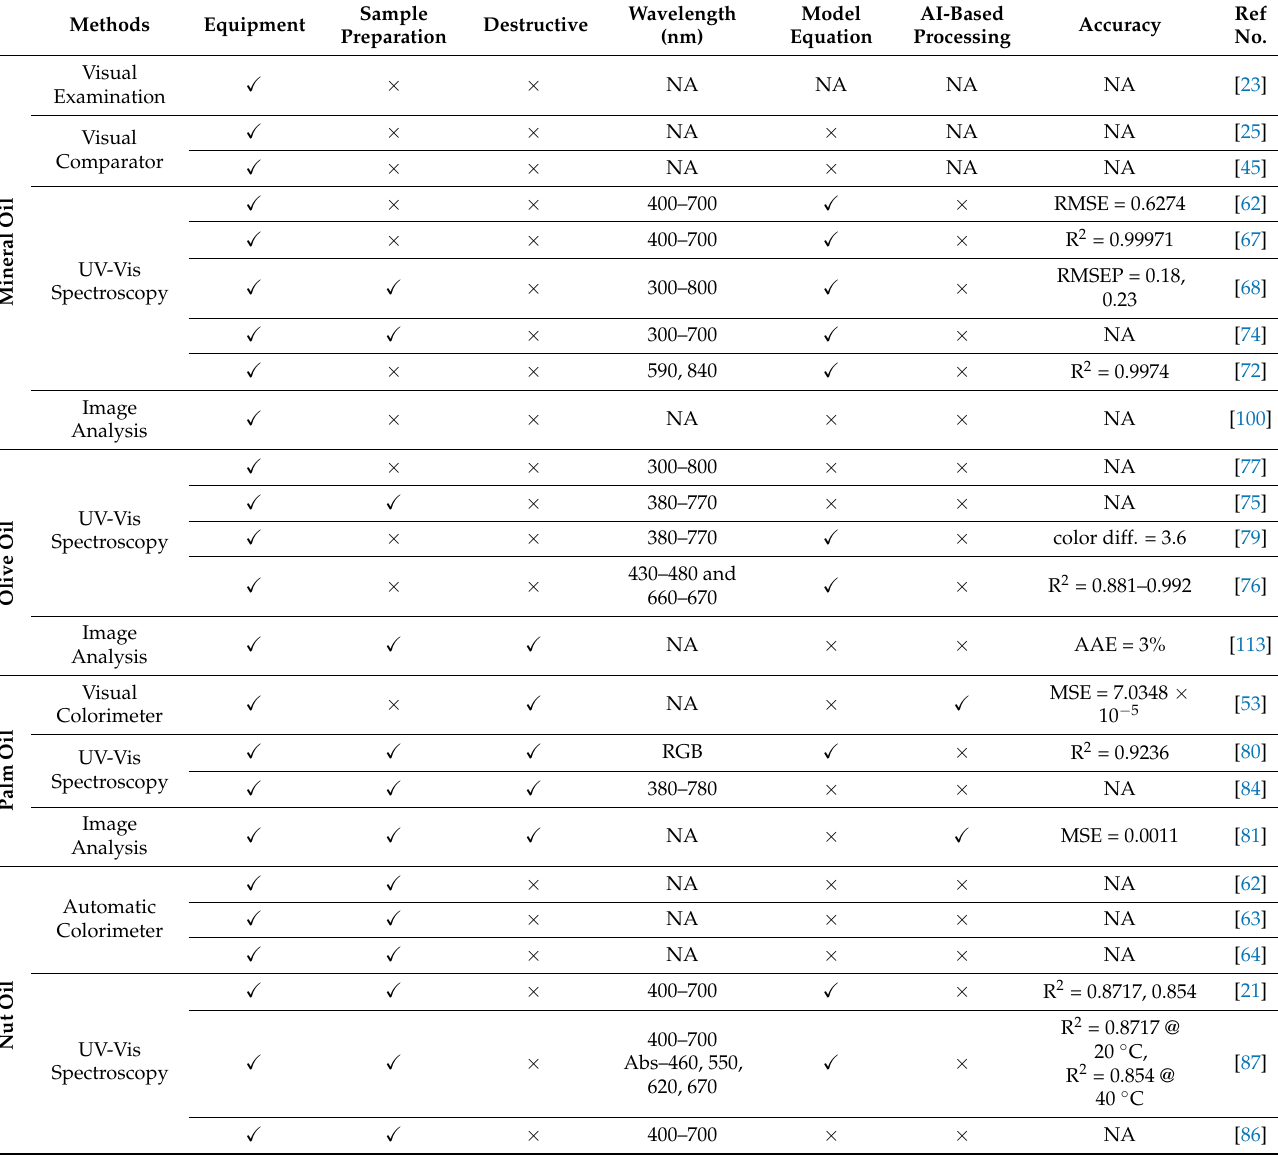
Table 21. Analysis of methods for color determination of amber-colored